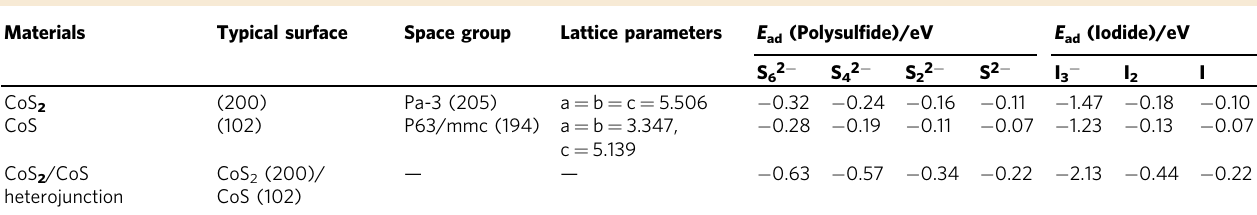
Table 1 Surface calculation data of CoS 2 , CoS, and CoS 2